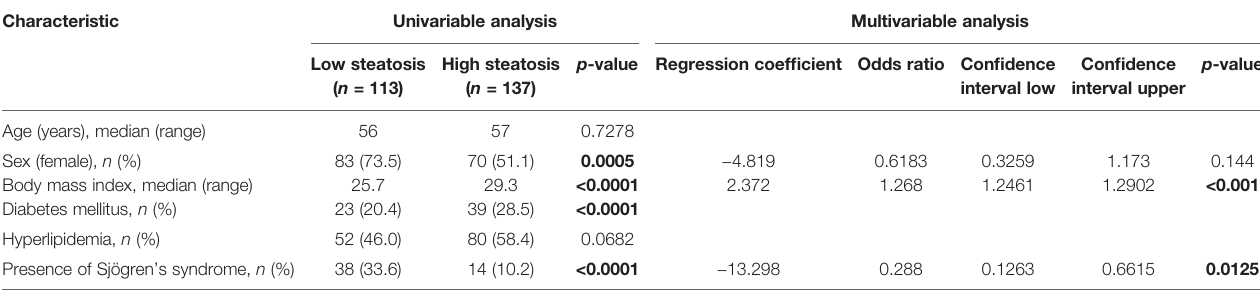
TABLE 3 | Comparison between study participants with low and high steatosis.